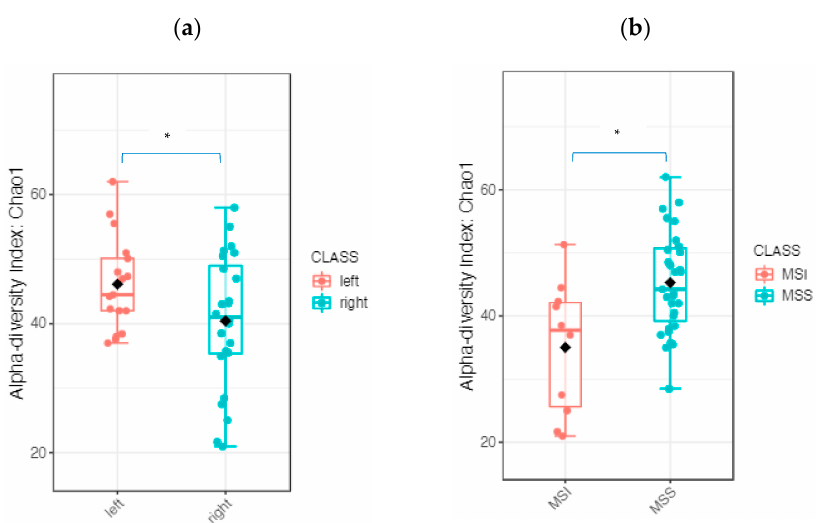
Figure 8. Tumor microbiome diversity comparison: the alpha diversity analysis revealed significant differences between RSCC and LSCC ( a ) and between MSS and MSI patients ( b ) at the genus level (* p < 0.05).